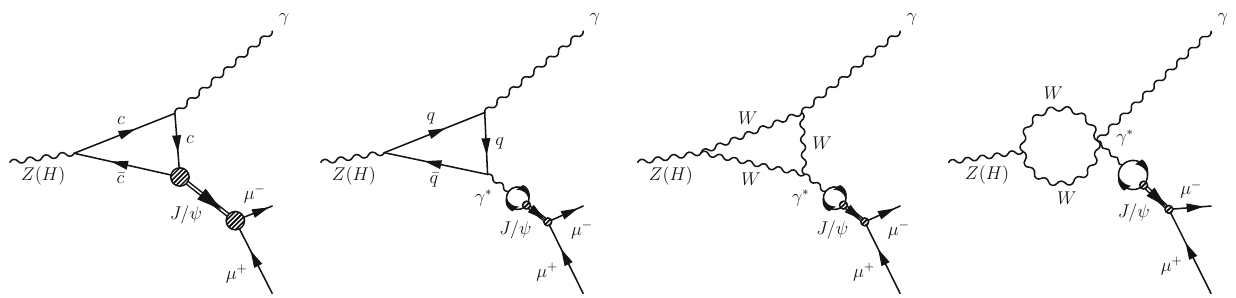
Fig. 1 Lowest order Feynman diagrams for the Z (or H) → J /ψγ decay. The left-most diagram shows the direct and the remaining diagrams the indirect